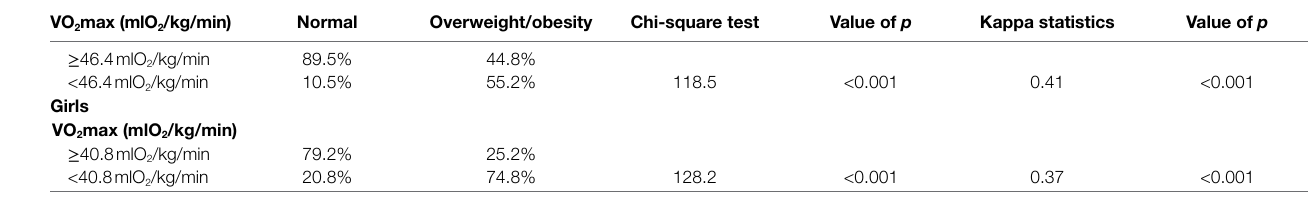
TABLE 3 | Sensitivity, specificity, and Kappa statistics for cardiorespiratory cut-offs and overweight/obesity in different anthropometric indices, stratified by gender. Boys